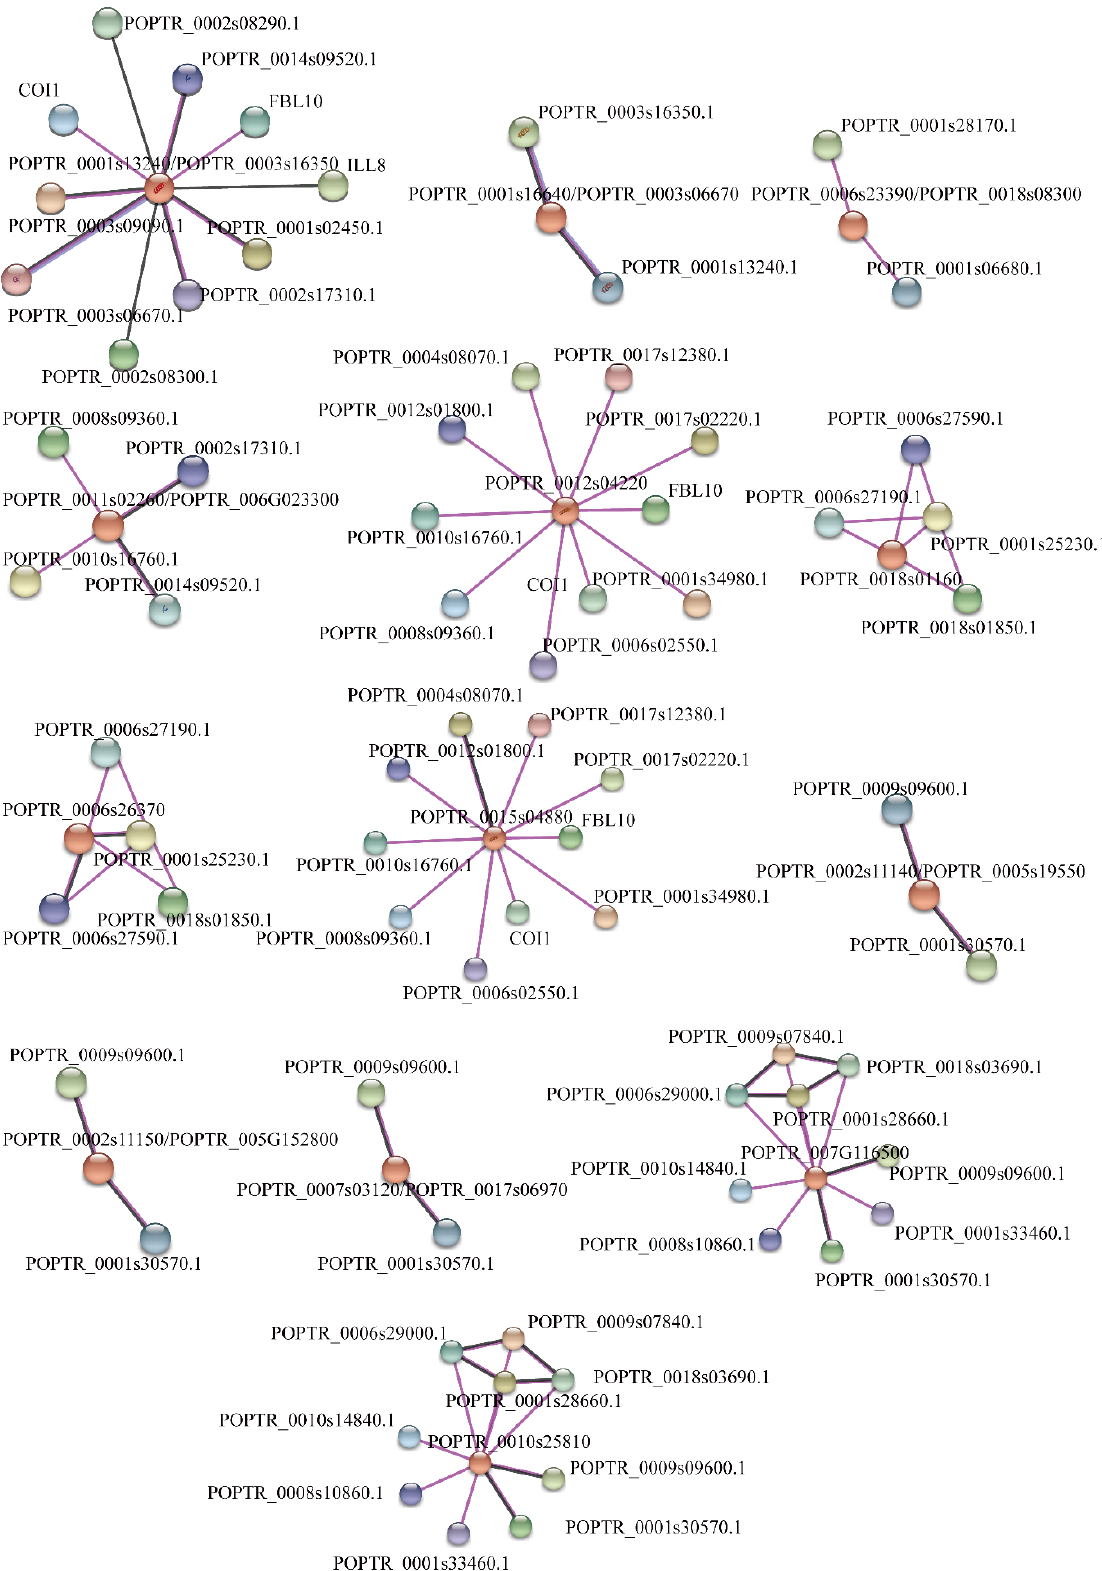
Figure 10. The predicted protein interaction network of PtrTIFY proteins by STRING database. Different colored lines represent different evidence of interaction.